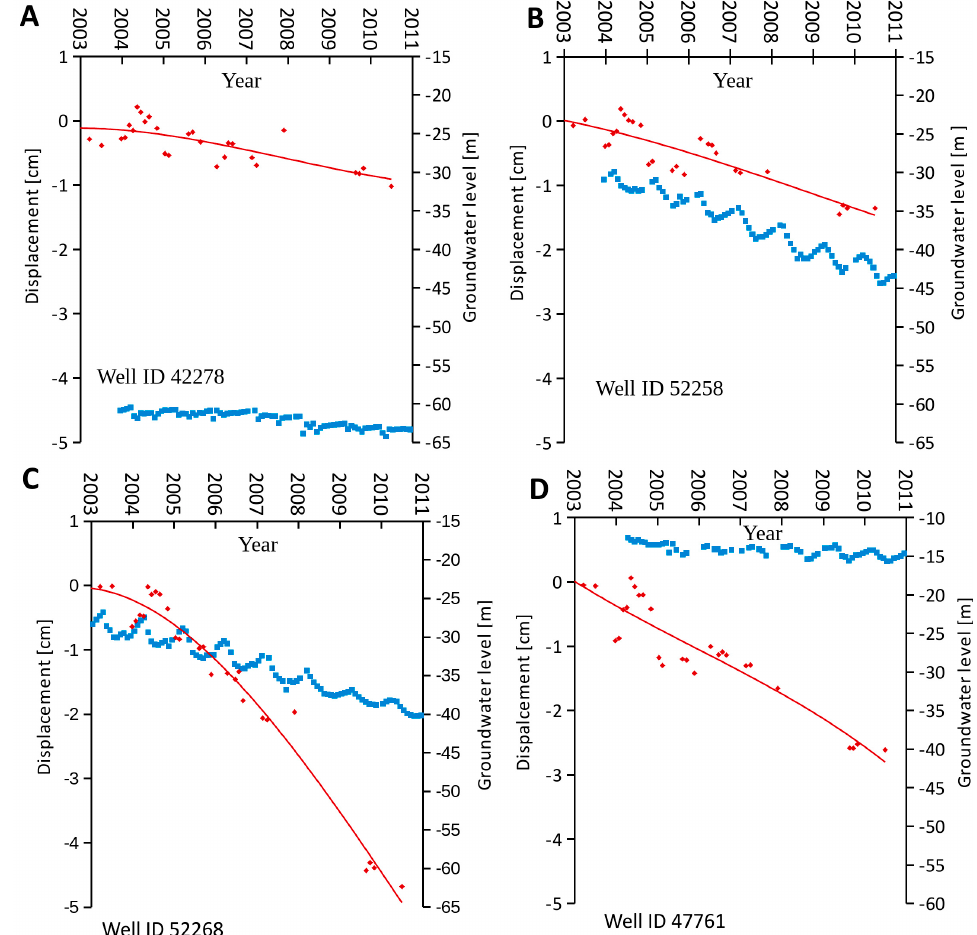
Figure 12. Average of DInSAR vertical deformation time-series ( red squares ) associated to SAR measure points located in similar geological and morphological units, within a distance variable from 1 to 2 km from the relevant well, vs. groundwater level measurements ( blue squares ). ( A , B ) refer to wells located on the limestone plateau and on the boundary between plateau and plain area, respectively. ( C , D ) refer to wells located within the plain area.